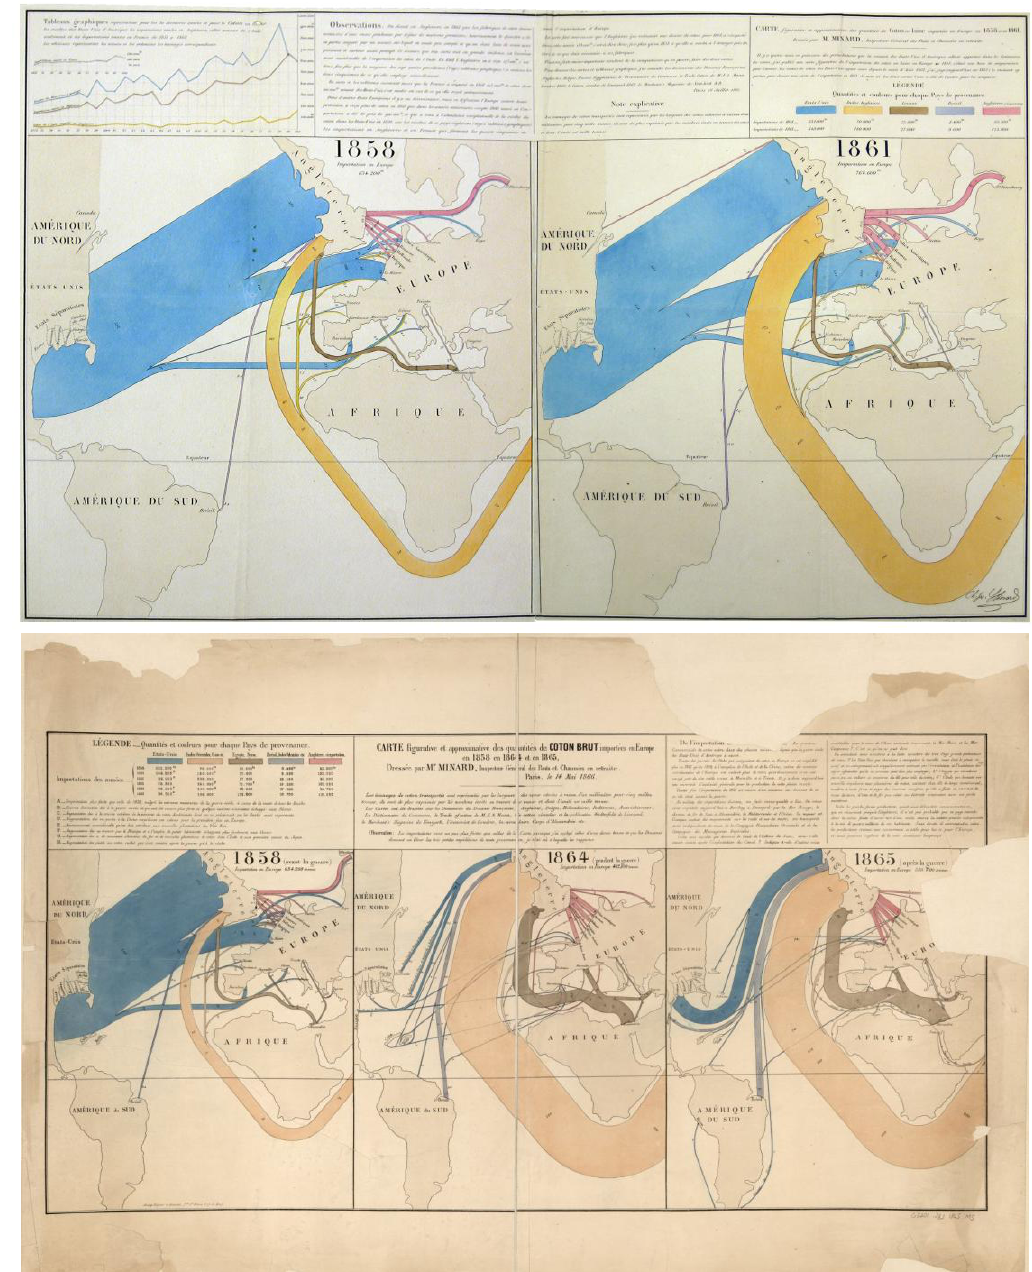
Figure 3. The map on the top, “Carte figurative et approximative des quantités de coton en laine emportées en Europe en 1858 et en 1861.” was published in 1862 and portrays data for 1858 and 1861. The map at the bottom, “Carte figurative et approximative des quantités de coton brut importées en Europe en 1858, en 1864 et en 1865.” was published in 1866 and depicts data for three year, 1858, 1864, and